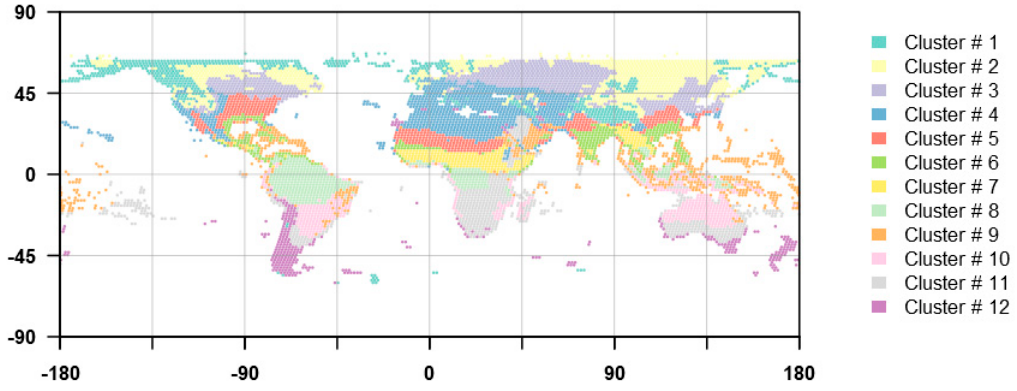
Figure 5. Cluster map, derived from a partitioning of the water vapor climatology and monthly variability of each location around medoids.